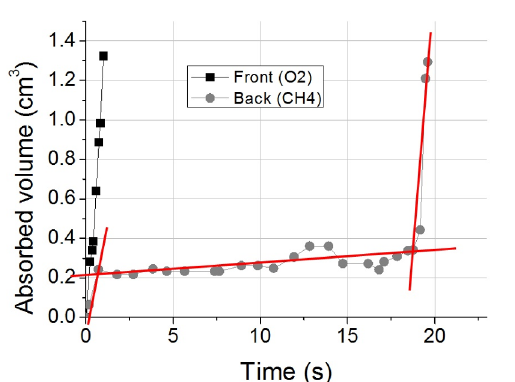
Figure 10. Amount of water absorbed on the two sides of the fabric treated with 100 W, 30 min and ratio of 40% CH